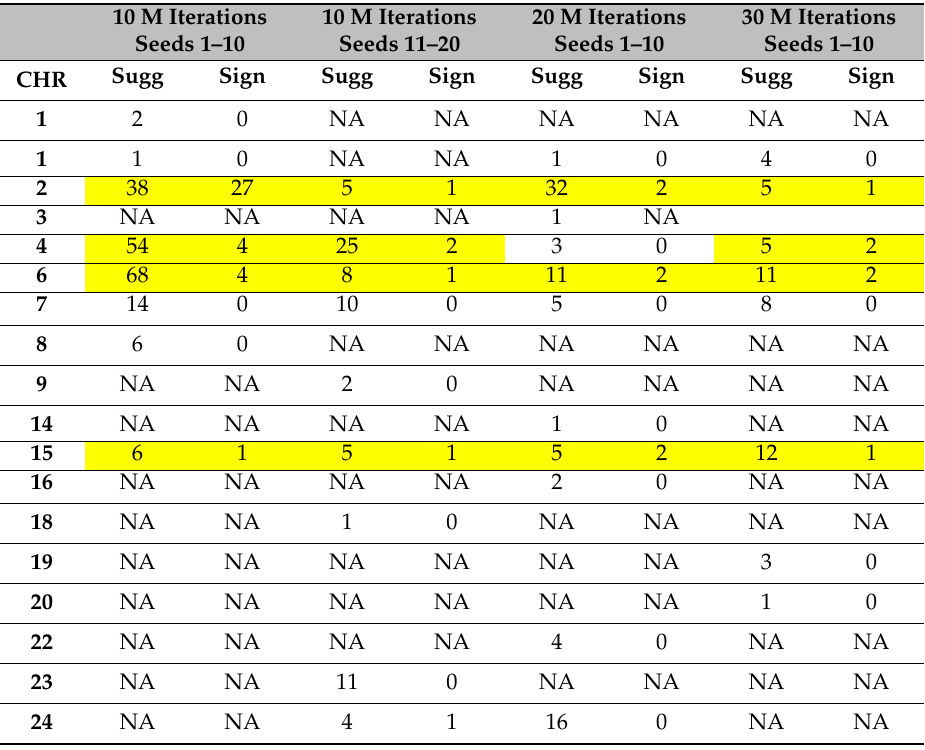
Table A1. Repeatability across results for the Bayesian sparse linear mixed model